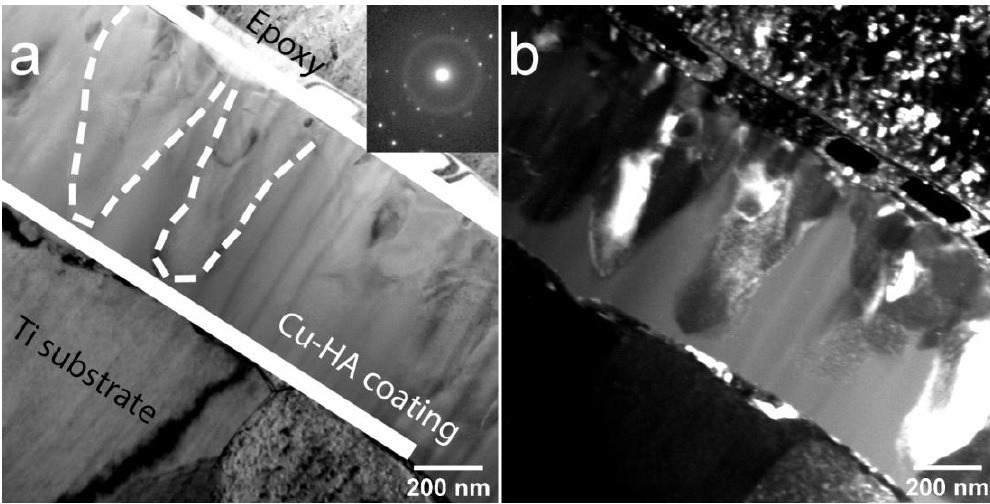
Figure 6. TEM image of the cross-section of Cu-HA coating on Ti after HT at 450 °C BF, the inset shows the corresponding electron diffraction pattern ( a ) and DF ( b ).